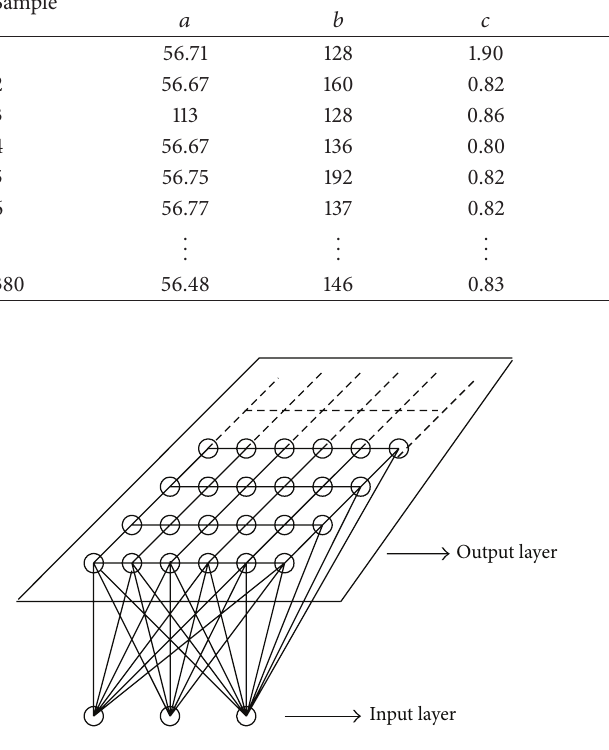
Figure 4: Structure of SOM neural network.